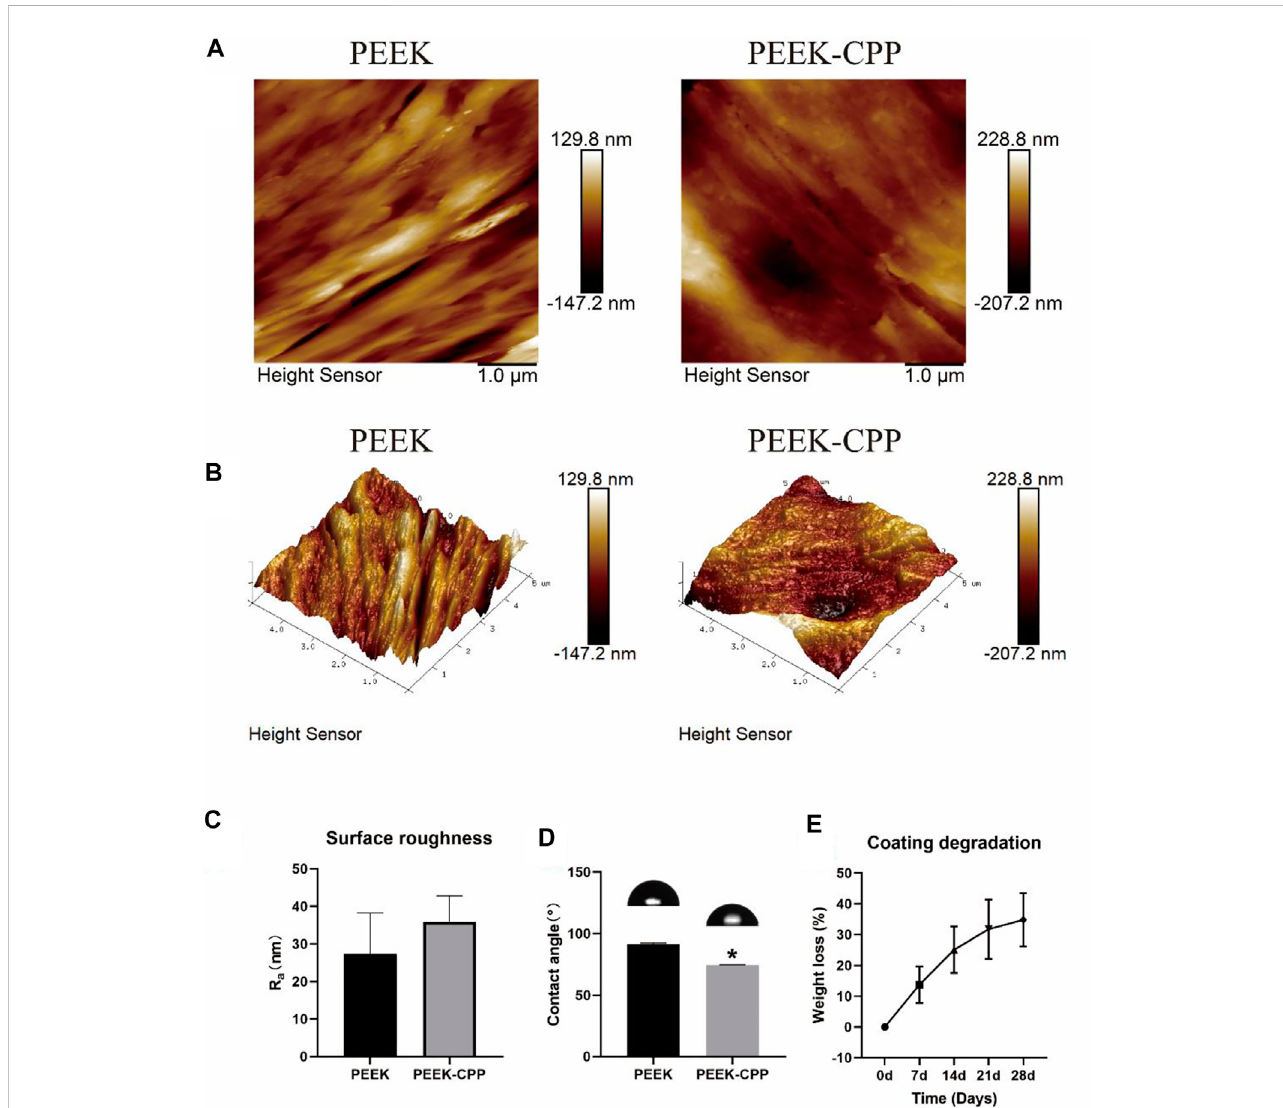
Surface characterization of different PEEK specimens and coating degradation test of PEEK-CPP specimens. (A, B) Two-dimensional and three- dimensional reconstructed morphologies by AFM observation. (C) Surface roughness ( n = 3). (D) Water contact angles ( n = 3). (E) Weight loss of the CPP coating ( n = 5). * The asterisk indicates statistically signi fi cant differences compared with PEEK ( p <